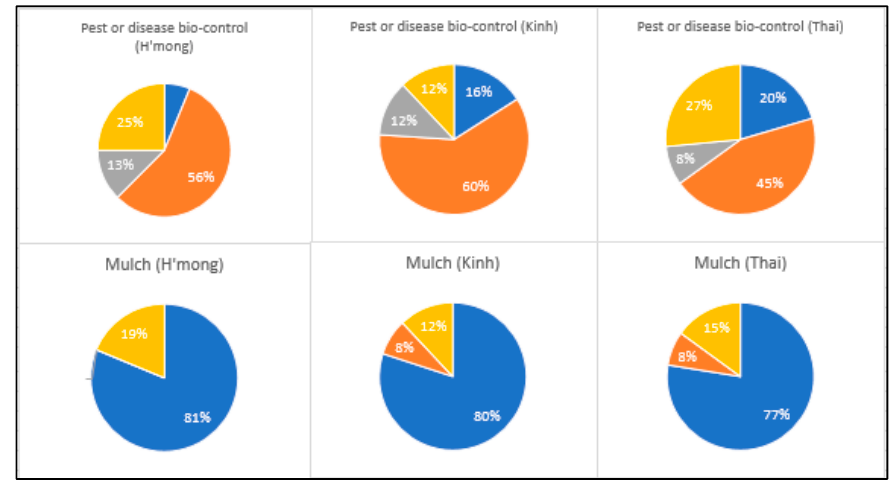
Figure A1. Farmers’ perception of tree services for coffee in coffee agroforestry systems by ethnicity.